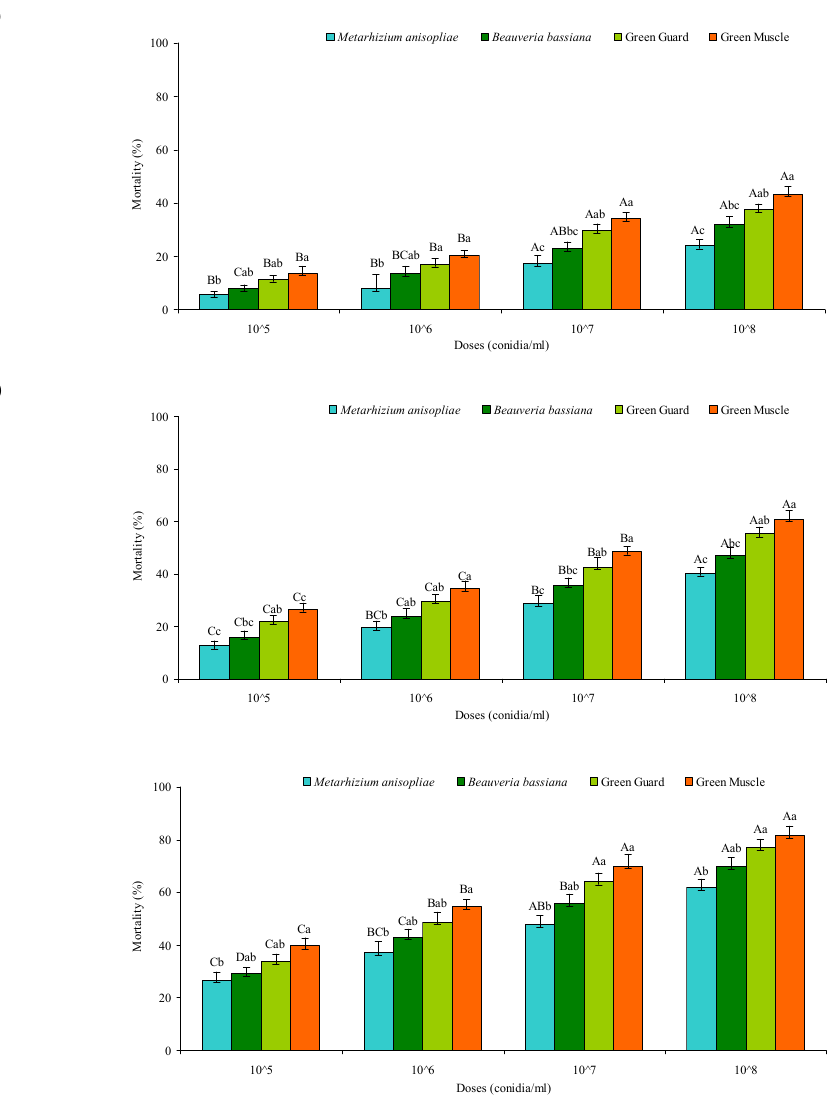
Figure 2. Mean mortality percentages ( ± SE) of 5th-instar nymphs of S. gregaria after ( a ) 5 days, ( b ) 7 days, and ( c ) 12 days of treatment with various doses (10 5 , 10 6 , 10 7 , and 10 8 conidia/mL) of Green Muscle, Green Guard, B. bassiana , or M. anisopliae . Mortality data were corrected for control mortality, which was <5%. For each subfigure: different lowercase letters indicate significant differences in mortality between each of the EPF; different uppercase letters indicate significant differences in mortality between doses (Tukey’s HSD test at p ≤ 0.05).